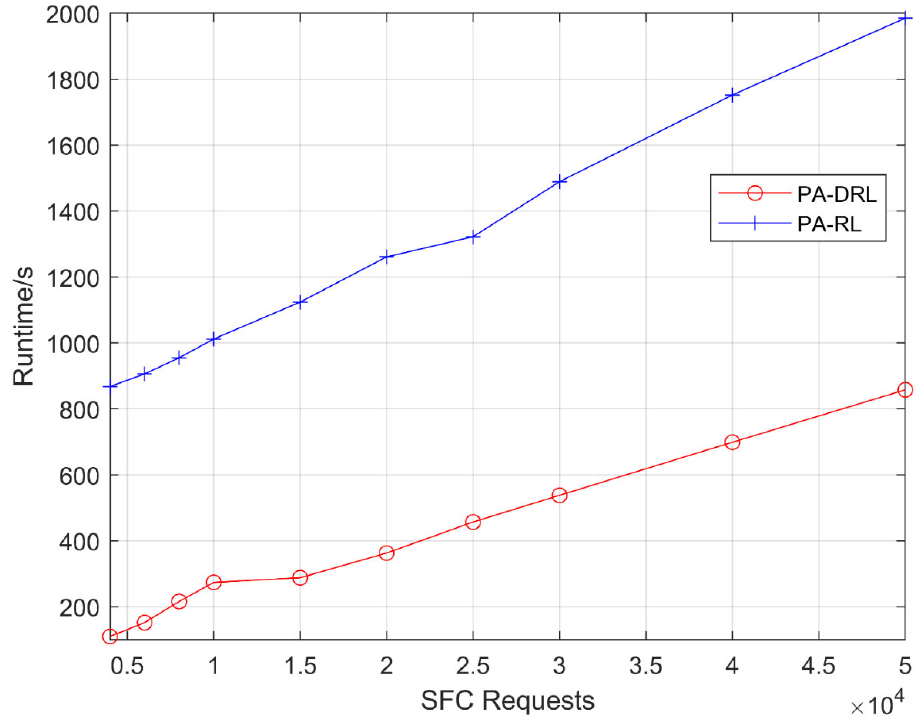
Figure 2. Runtime of PA ‐ DRL and PA ‐ RL under each SFC requests